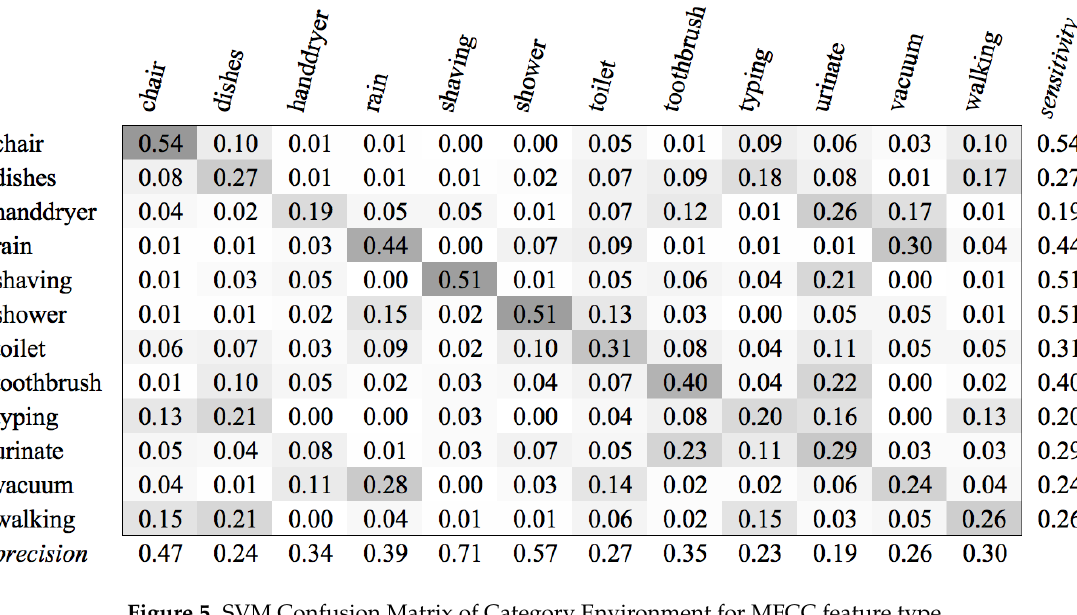
Figure 5. SVM Confusion Matrix of Category Environment for MFCC feature